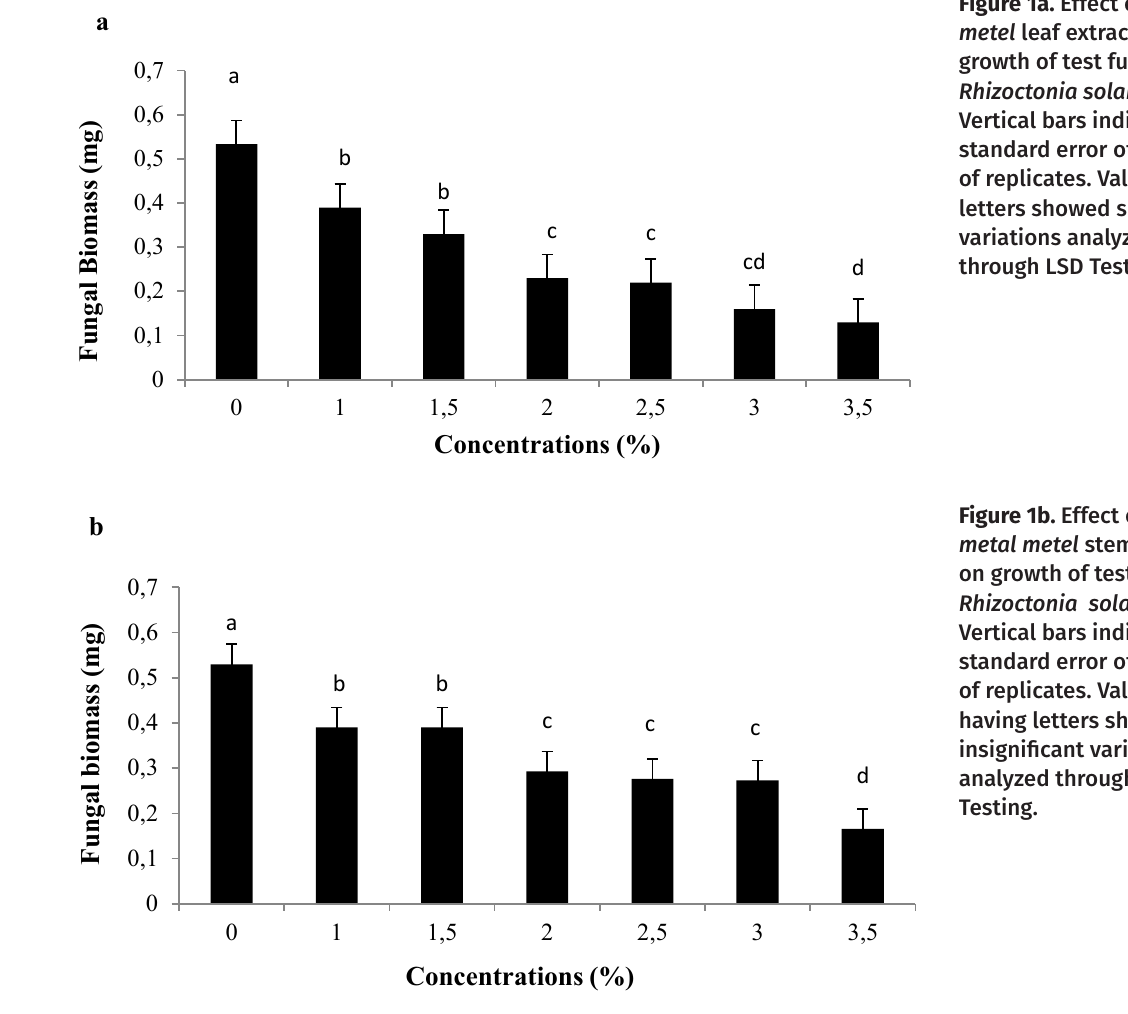
Figure 1b. Effect of Datura metal metel stem extract on growth of test fungus Rhizoctonia solani . Vertical bars indicated standard error of means of replicates. Values having letters showed insignificant variations analyzed through LSD